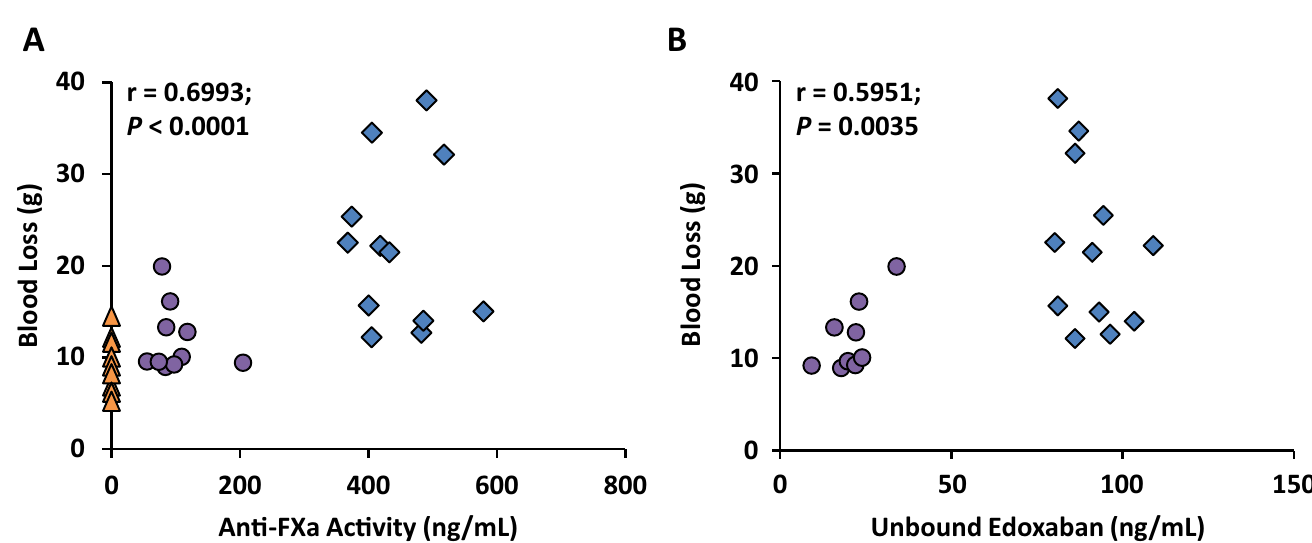
Fig 8. Correlation between blood loss and pharmacodynamic markers in edoxaban-anticoagulated rabbits. Blood loss correlated with (A) anti-FXa activity and (B) unbound edoxaban plasma concentrations. Each data point represents the measurements from an individual rabbit at the end of andexanet infusion (Time 25 minutes) for anti-FXa and unbound edoxaban, and 15 minutes after liver injury for blood loss (Time 40 minutes). 4 vehicle alone (both edoxaban + andexanet vehicle); (cid:14) edoxaban + andexanet; (cid:5) edoxaban + andexanet vehicle.